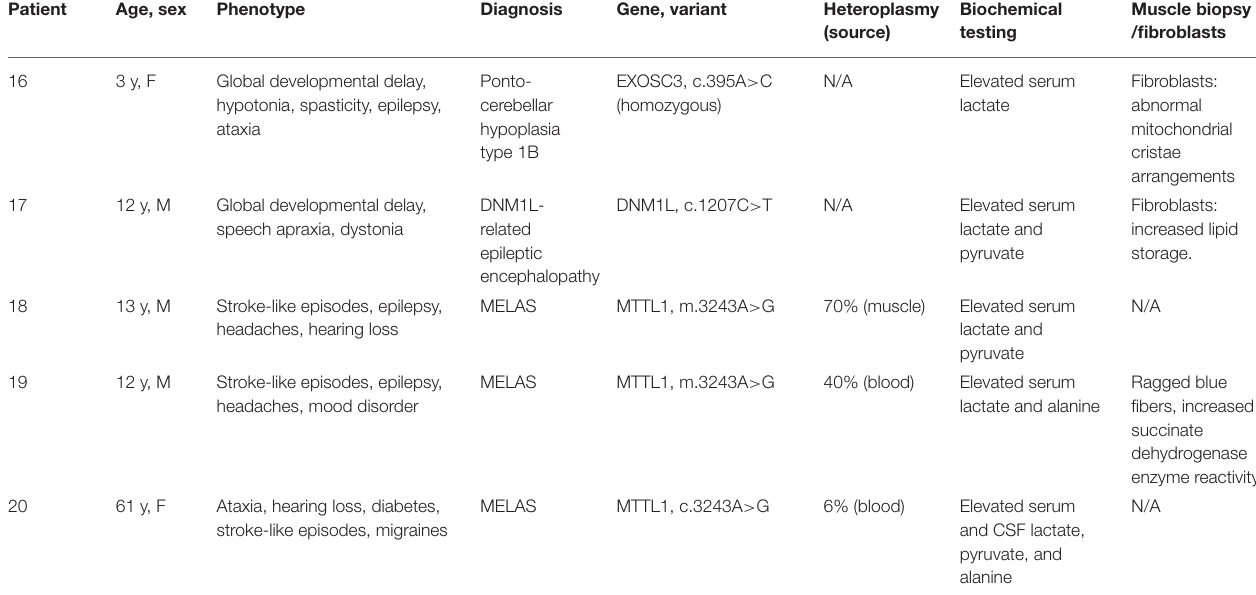
Consecutive MRIs were performed in 17 patients and imaging evidence of disease progression was present in 11 patients [six patients with MELAS, two patients with POLG1, and the patients with MERRF, exosome component 3 (EXOSC3), and dynamin-like protein 1 (DNM1L)]. In the patients with MELAS, T2 hyperintensities and/or DWI